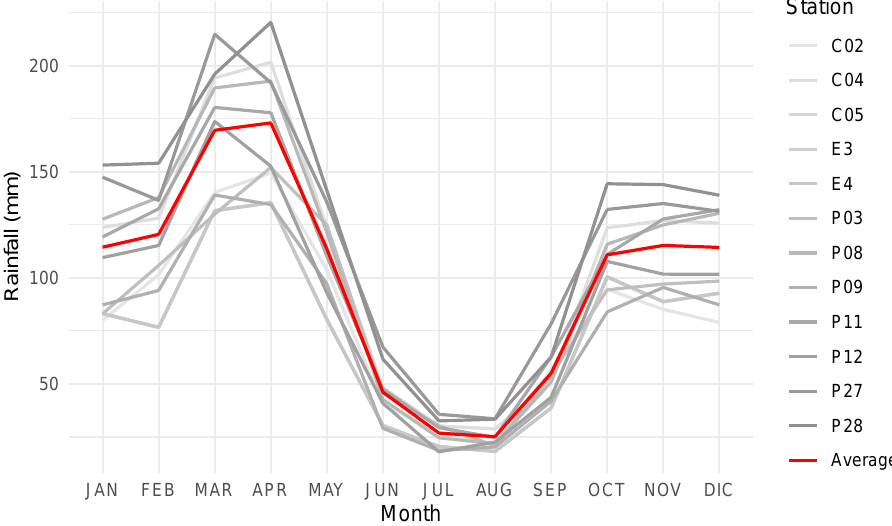
Figure 2. Multi-year monthly rainfall of each station (bluish) and Multi-year monthly mean rainfall (red) of El Batán sub-basin.